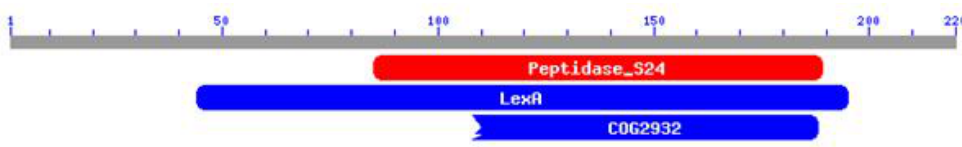
Figure 3: Diagrammatic illustration of conserved LexA transcriptional regulatory protein domains in D. radiodurans . Domain belongs to Peptidase_S24 family and showed protein sequence sharing with both LexA and COG2932